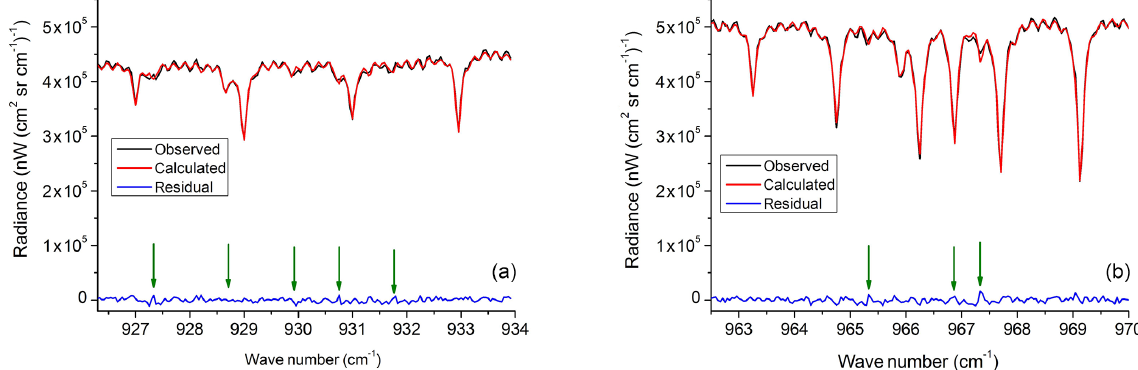
Figure 3. Observed (black line) and calculated spectrum (red line) in radiance unit (nW(cm 2 srcm − 1 ) − 1 ) for both spectral windows mea- sured with the Bruker Vertex 80 in Créteil on 21 March 2012, with the fitting residuals (blue line). Green arrows indicate locations of the strong ammonia features in the